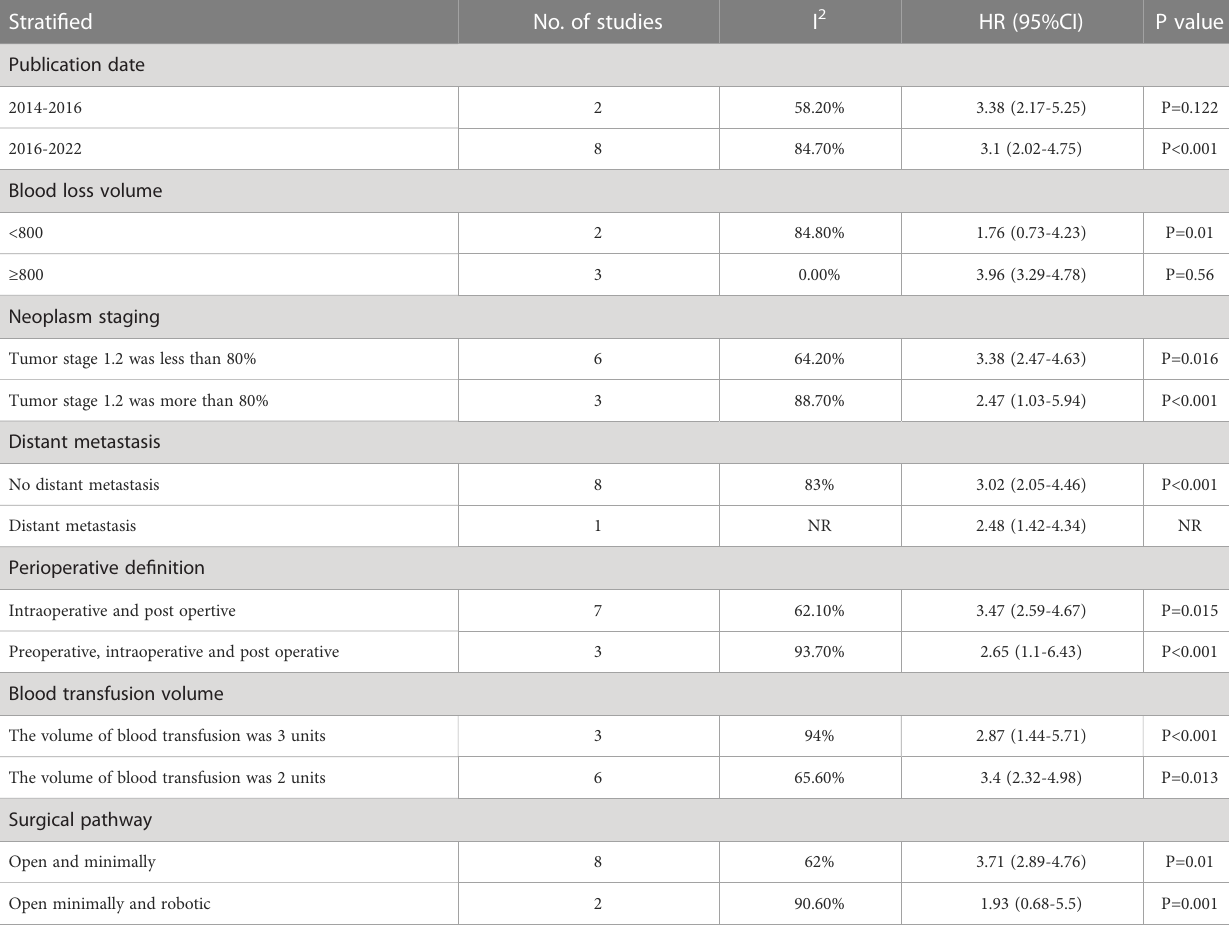
TABLE 2 Subgroup analysis of cancer-speci fi c survival.